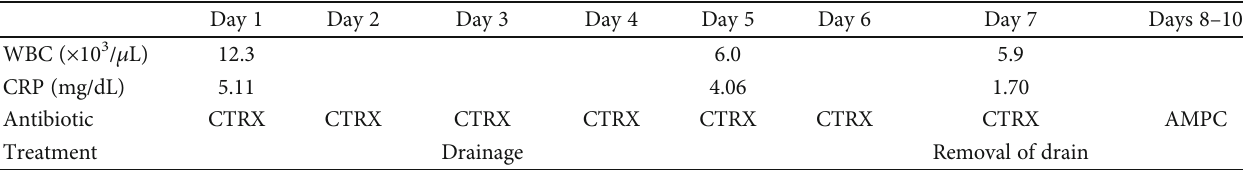
Table 1: Laboratory data and clinical course of Case